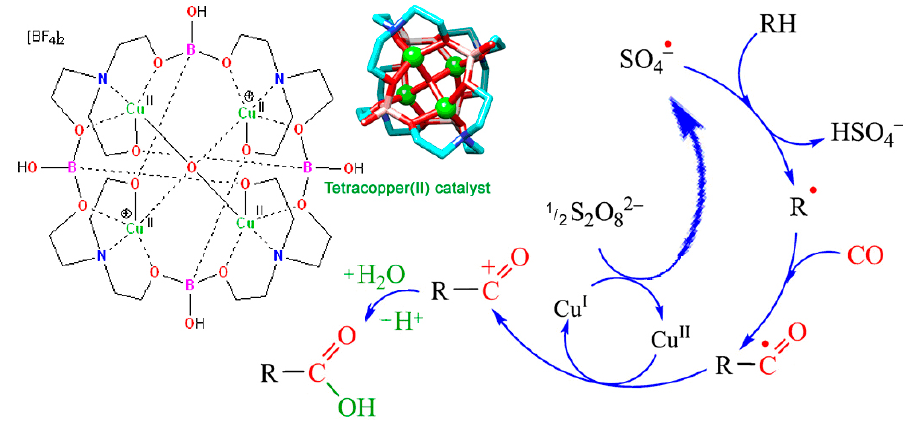
Figure 24. Alkane (RH) carboxylation with S 2 O 82 ‒ /CO system catalyzed by a copper salt. Adapted from Refer. [313].